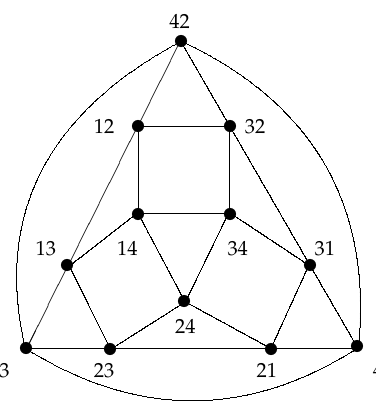
Figure 1. The arrangement graph A 4,2 .